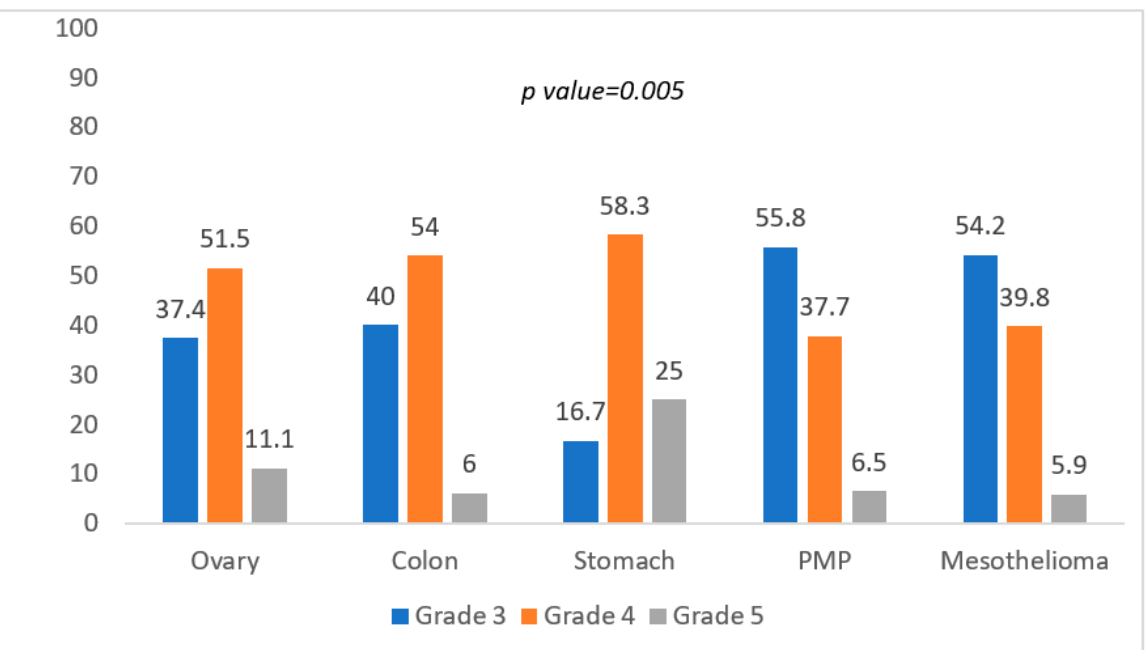
Figure 2. Association between grading of complications and histology.